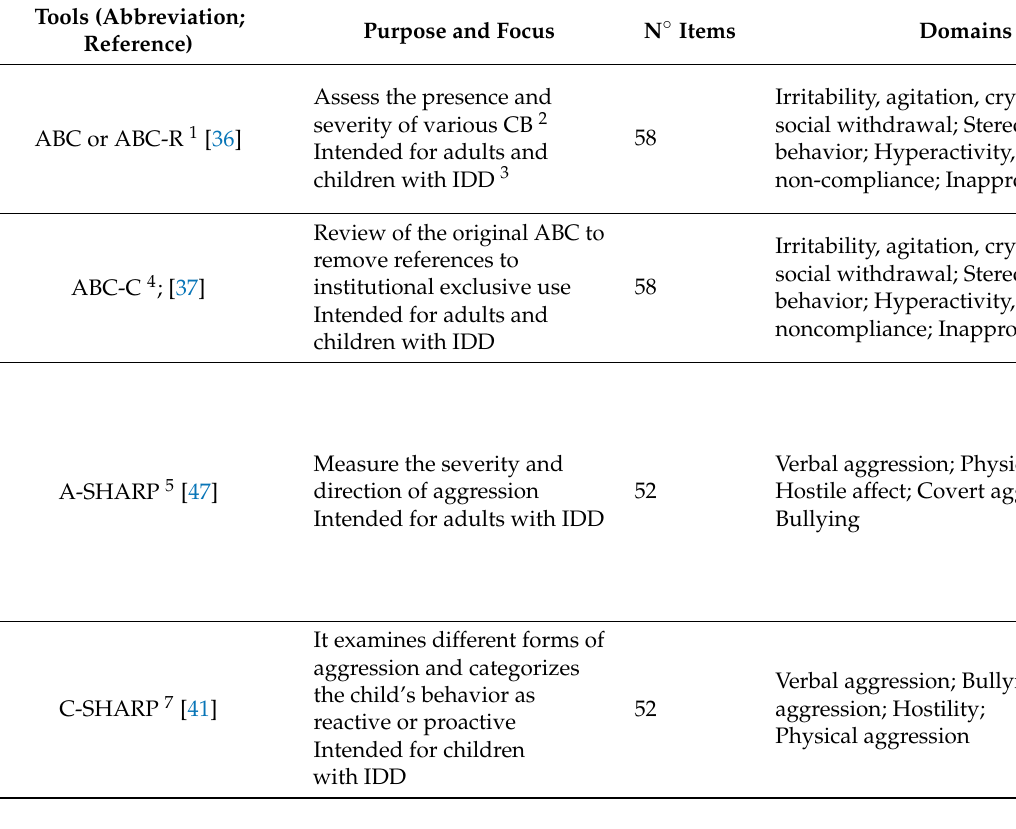
Table 1. Studies comprising the systematic review ( n =